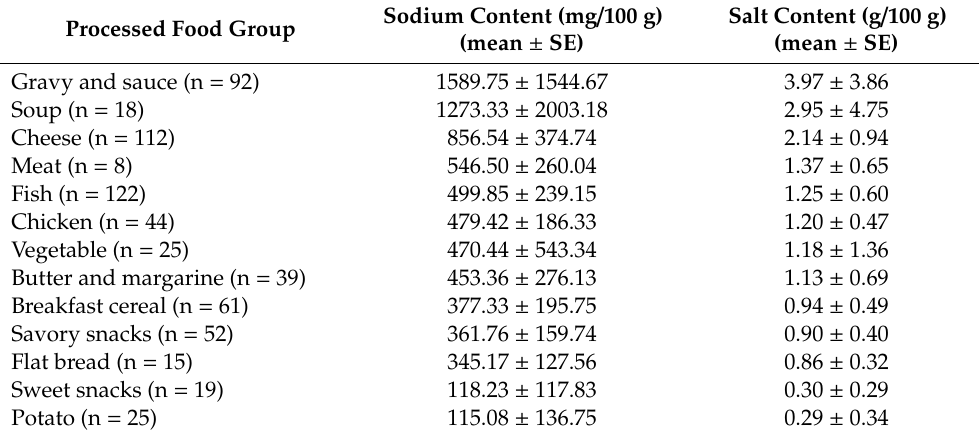
Table 3. The average sodium and salt content in processed food groups reported in mean ± standard